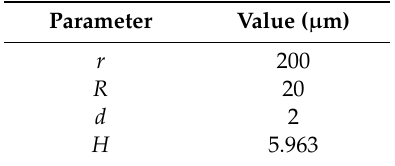
Table 1. Parameter-Value correspondence table.